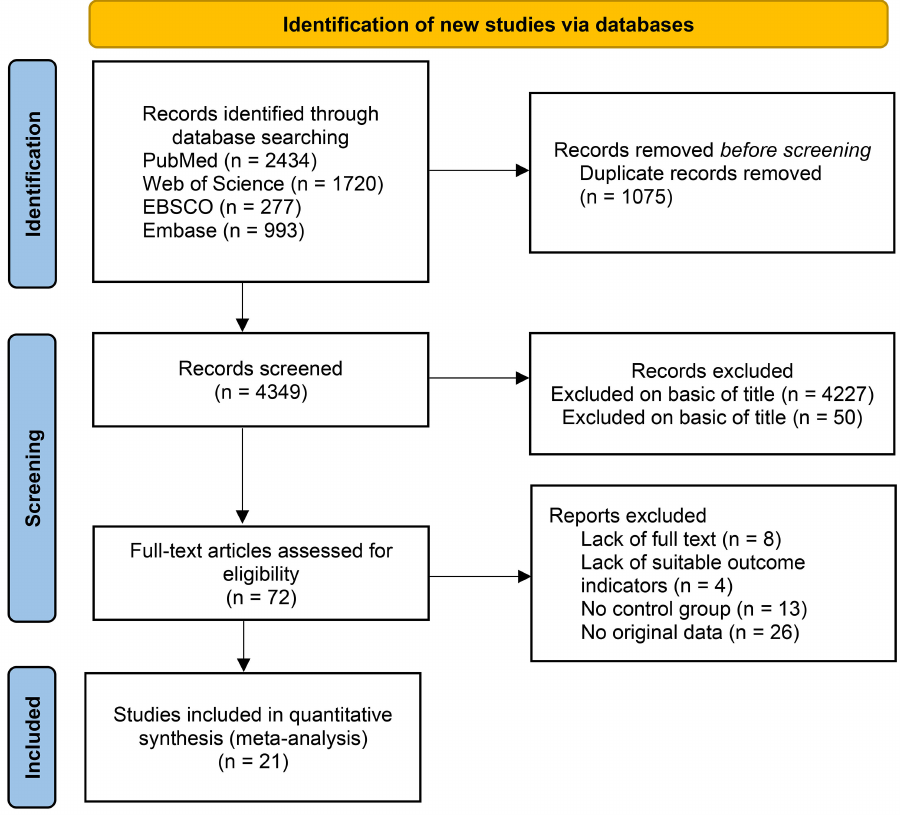
Figure 1. Flowchart illustrating the different phases of the search and study